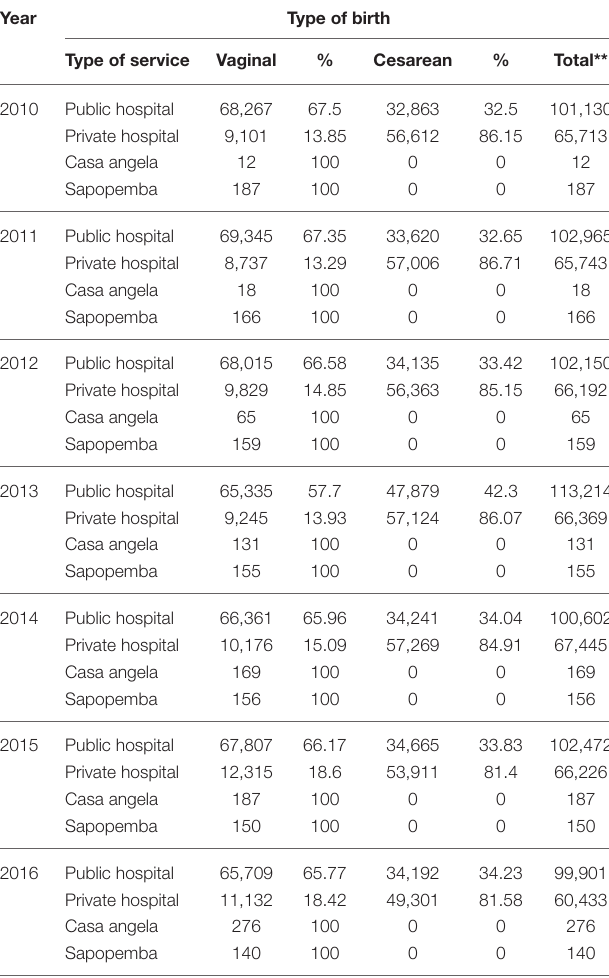
TABLE 2 | Distribution of number and percentage of types of birth according to type of financing for care in the city of São Paulo, between the years 2010